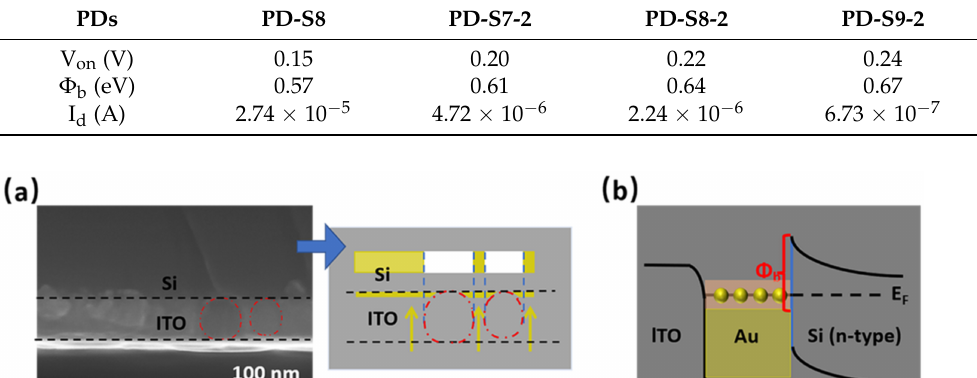
Figure 4. ( a ) Cross-sectional SEM image (left) of the ITO/Au/Au NPs/Si structure (PD-S8-2) with a schematic diagram of the Au atoms’ deposition path to the NPs (right). The area surrounded by the red-dotted line embedded in ITO is the hole after the Au NP fell off due to the sample preparation. These nearly spherical NPs block the subsequent deposited Au atoms, resulting in the blind regions covered with ITO instead of Au at the bottom of the NPs. ( b ) Energy band diagram of the ITO/Au/Au NPs/Si